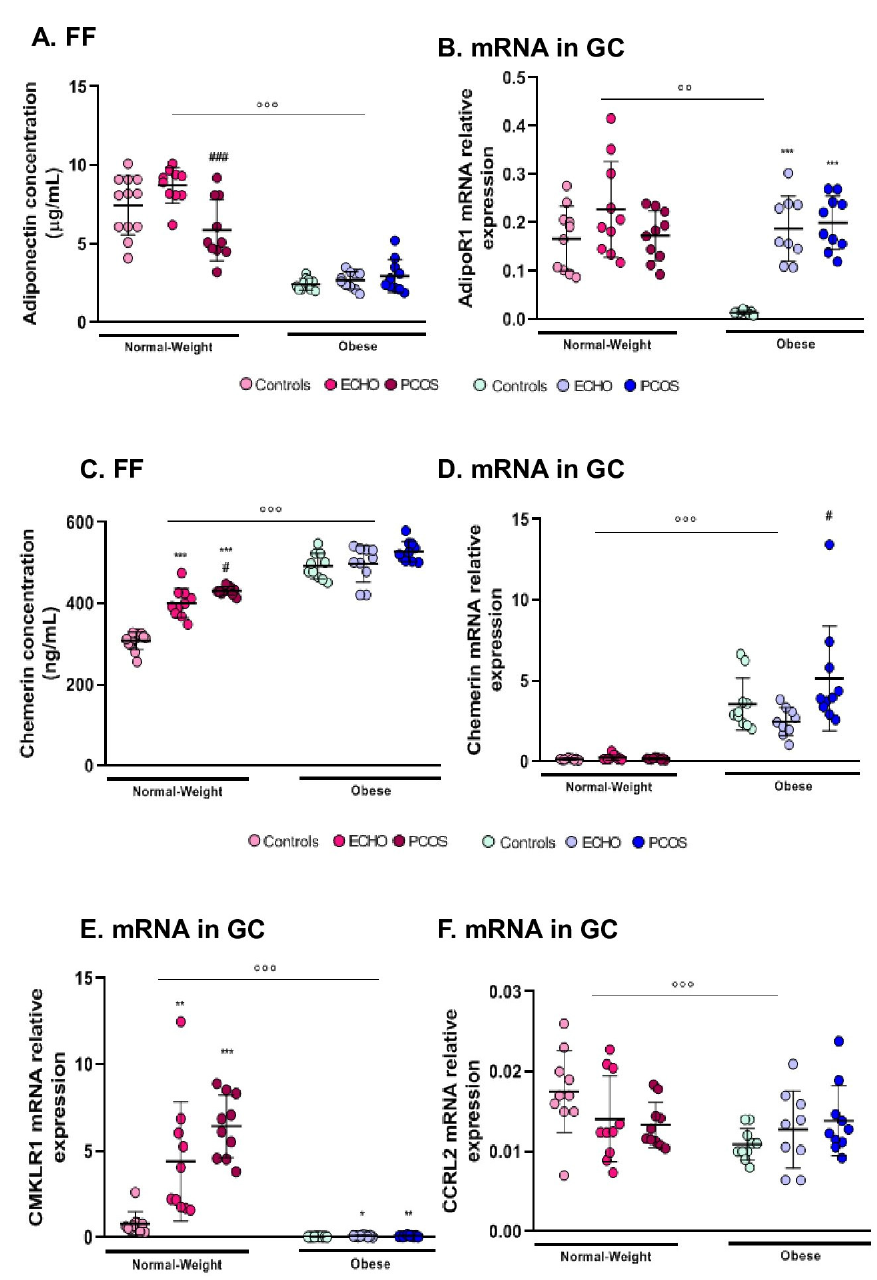
Figure 2. Follicular fluid adiponectin and chemerin concentration and mRNA expression of AdipoR1(Adiponectin receptor 1), CMKLR1, and CCRL2 in granulosa cells of obese and normal-weight PCOS, ECHO, and control groups. ( A ) Follicular fluid (FF) adiponectin concentration assessed by ELISA and ( B ) AdipoR1 mRNA levels in granulosa cells (GCs) quantified by RT-PCR within the six di ff erent groups; ( C, D ) chemerin levels in FF and GC; ( E, F ) mRNA levels of CMKLR1 and CCLR2 in GC. The values are expressed as mean ± standard errors of means ( n = 12 for normal-weight controls, n = 13 for normal-weight ECHO, n = 13 for normal-weight PCOS, n = 15 for obese controls, n = 15 for obese ECHO, and n = 10 for obese PCOS). ◦ indicates significant di ff erence between normal-weight and obese subjects ( ◦◦ p < 0.01, ◦◦◦ p < 0.001); * indicates significant di ff erence vs. controls (*** p < 0.001); # indicates significant difference vs. ECHO women (# p < 0.05, # # # p < 0.001).